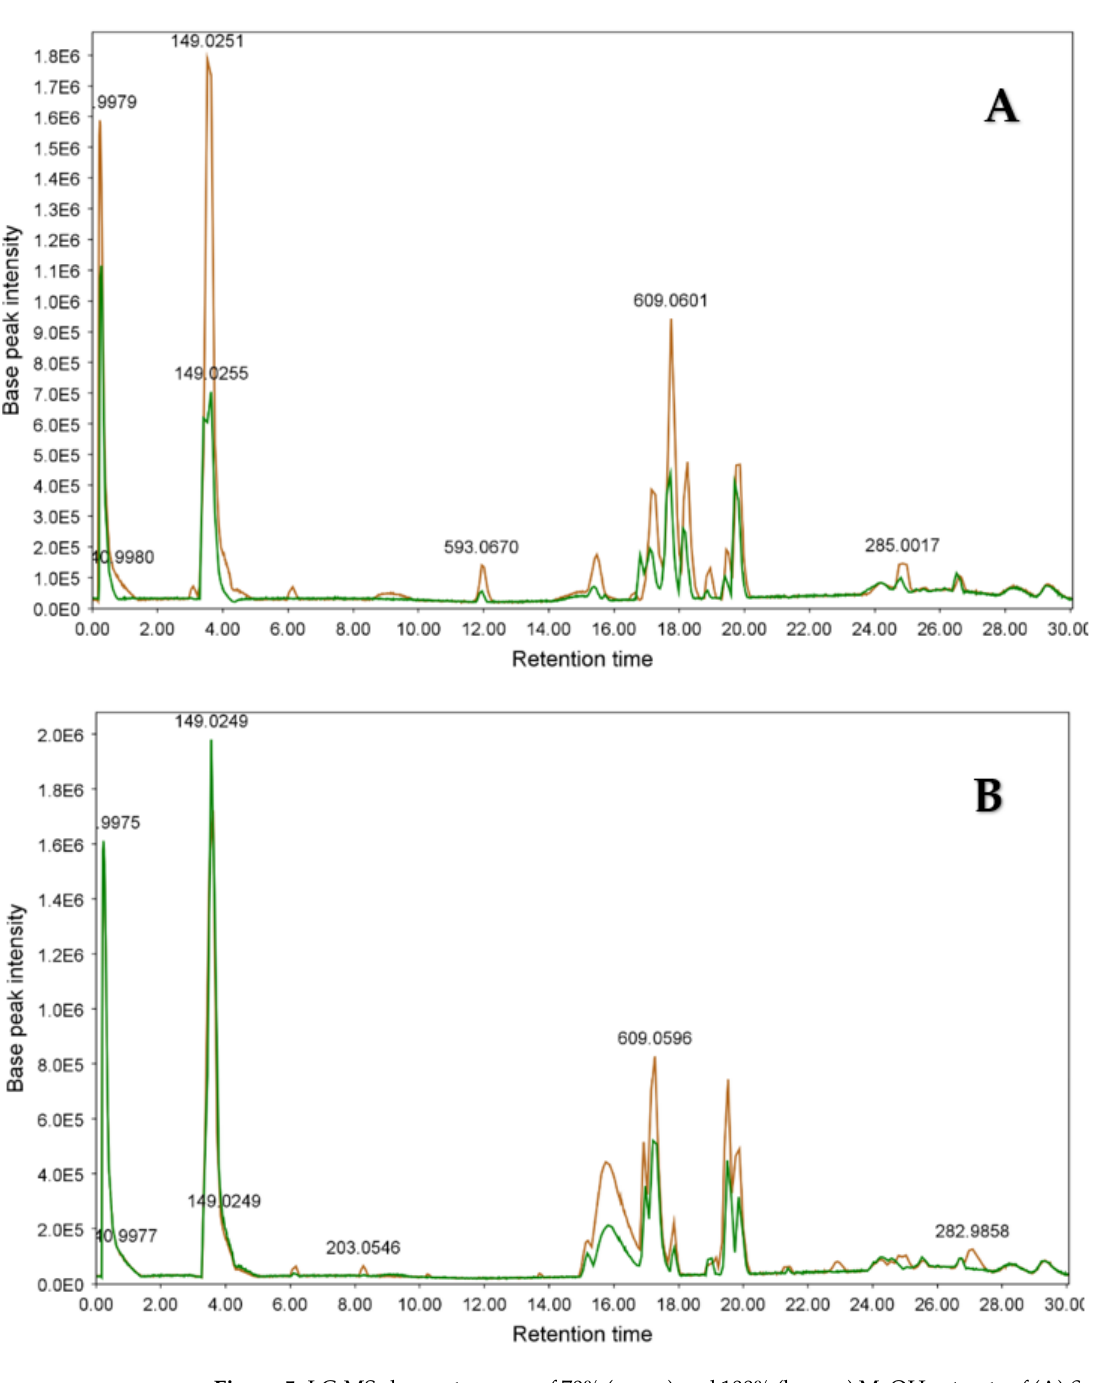
Figure 5. LC-MS chromatograms of 70% (green) and 100% (brown) MeOH extracts of ( A ) S. alexandrina and ( B ) S. italica. For the separation, XBridge ® BEH C18 column (150 × 3.0 mm i.d., particle size 2.5 µ m; Waters), gradient elution with MeOH and 0.2% aqueous acetic acid with a flow rate 0.2 cm 3 min − 1 were used. E5: 10 5 , E6: 10 6 . (For interpretation of the references to color in this figure legend, the reader is referred to the web version of this article.)